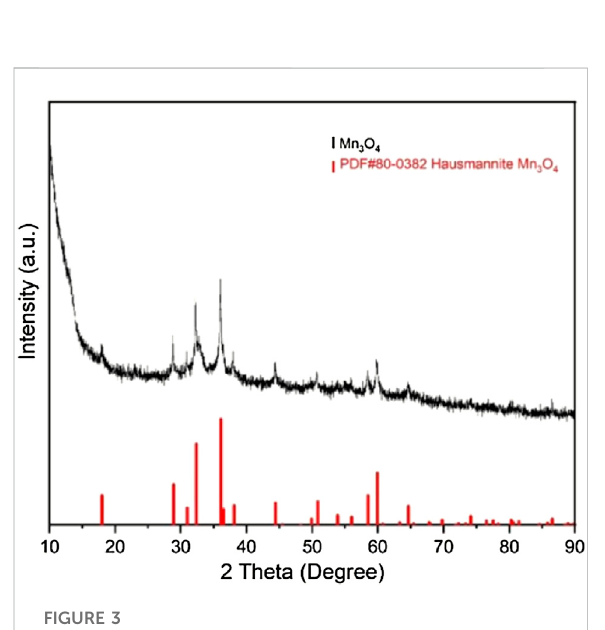
FIGURE 3 XRD pattern of nanosized Mn 3 O 4 powders.